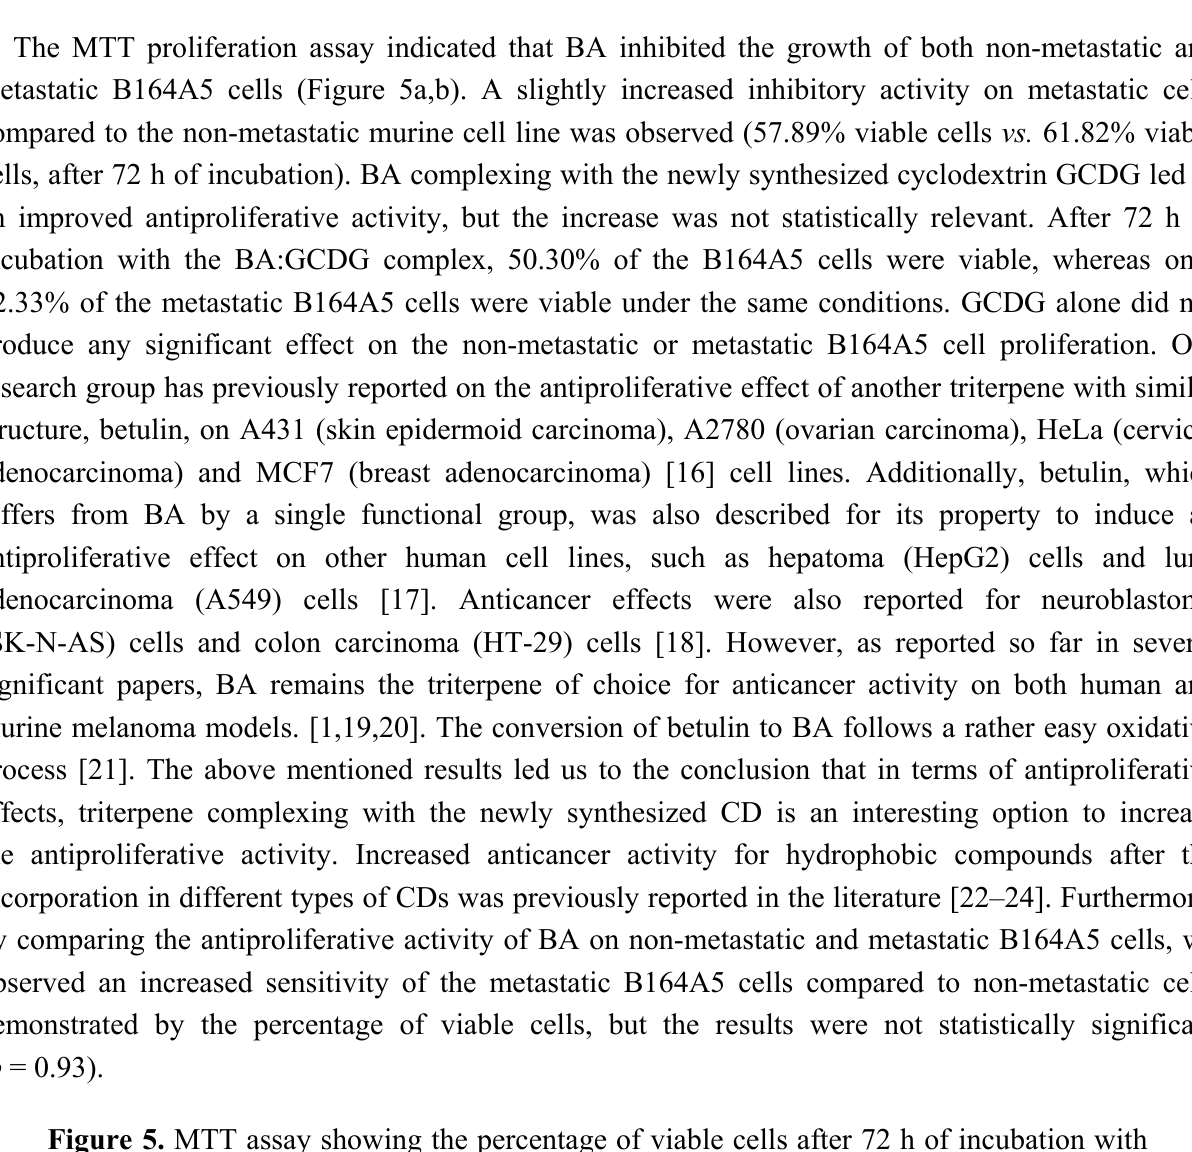
Figure 5. MTT assay showing the percentage of viable cells after 72 h of incubation with 10 mM BA and BA:GCDG 1:1 for non-metastatic ( a ) and metastatic ( b ) B164A5 cells. ns means not significant